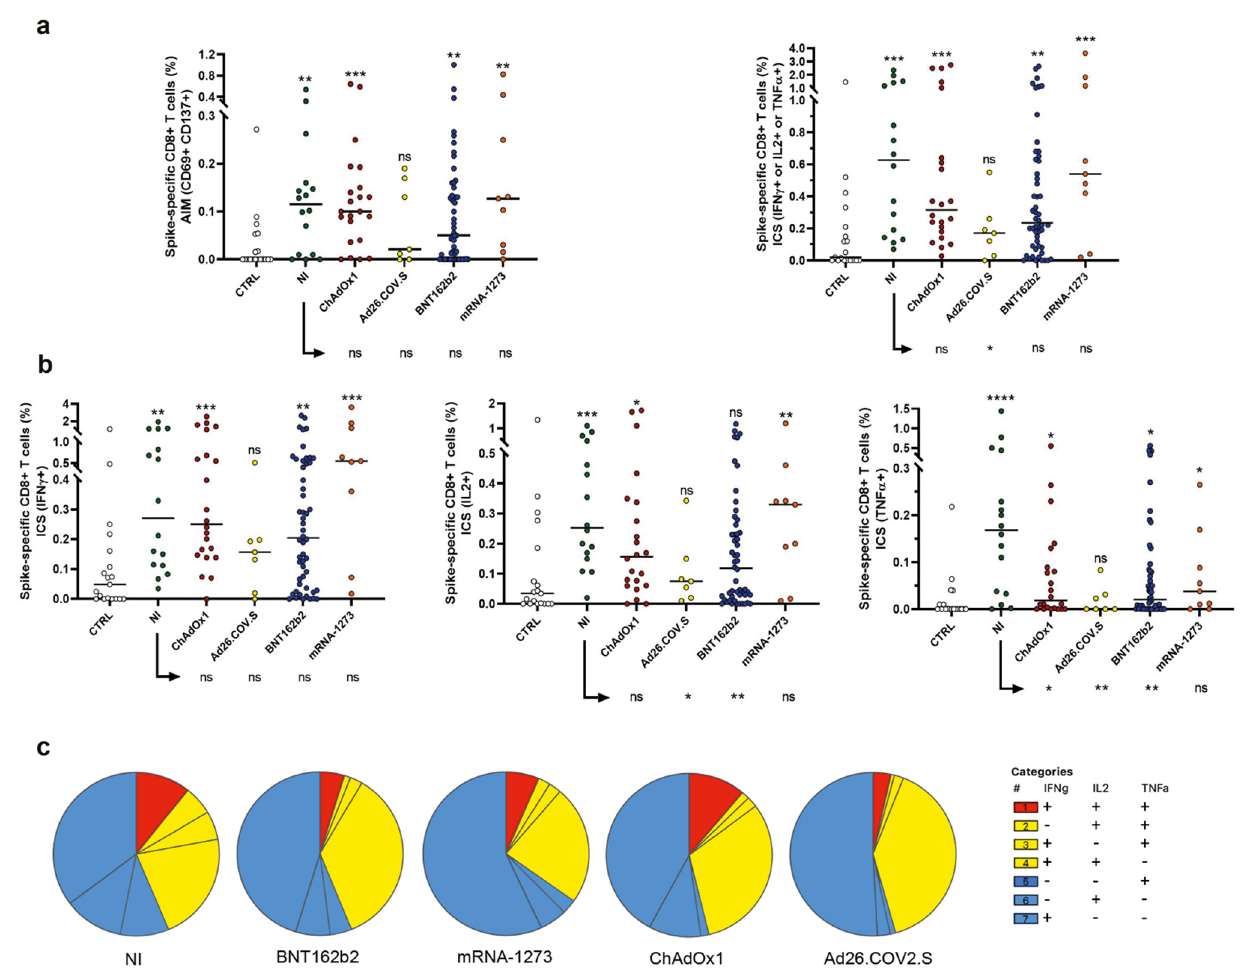
Figure 3. AIM and ICS of spike-specific CD8 + T cells. Frequencies of CD8 + T cells expressing T-cell activation markers ( a ) and producing antigen-specific cytokines ( b ) are shown in SARS-CoV-2 unexposed healthy donors who never received any anti-SARS-CoV-2 vaccine (CTRL), in resolved natural infections (NI), and in donors vaccinated with two doses of ChAdOx1, a single dose of Ad26.COV2.S, and two doses of BNT162b2 and mRNA-1273 vaccines. Frequencies were obtained by subtracting from the values of the stimulated samples the background produced by the related unstimulated tube. Individual data points are represented as scatter dot plots with lines showing the median value. ( c ) Pie charts show the expression of cytokine combinations from CD8 + T cells following spike stimulation. Significance was calculated using nonparametric Mann–Whitney U -tests (two-tailed). A p -value <0.05 was considered statistically significant. [ns ( p > 0.05), * ( p < 0.05), ** ( p < 0.005), *** ( p < 0.0005), **** ( p <